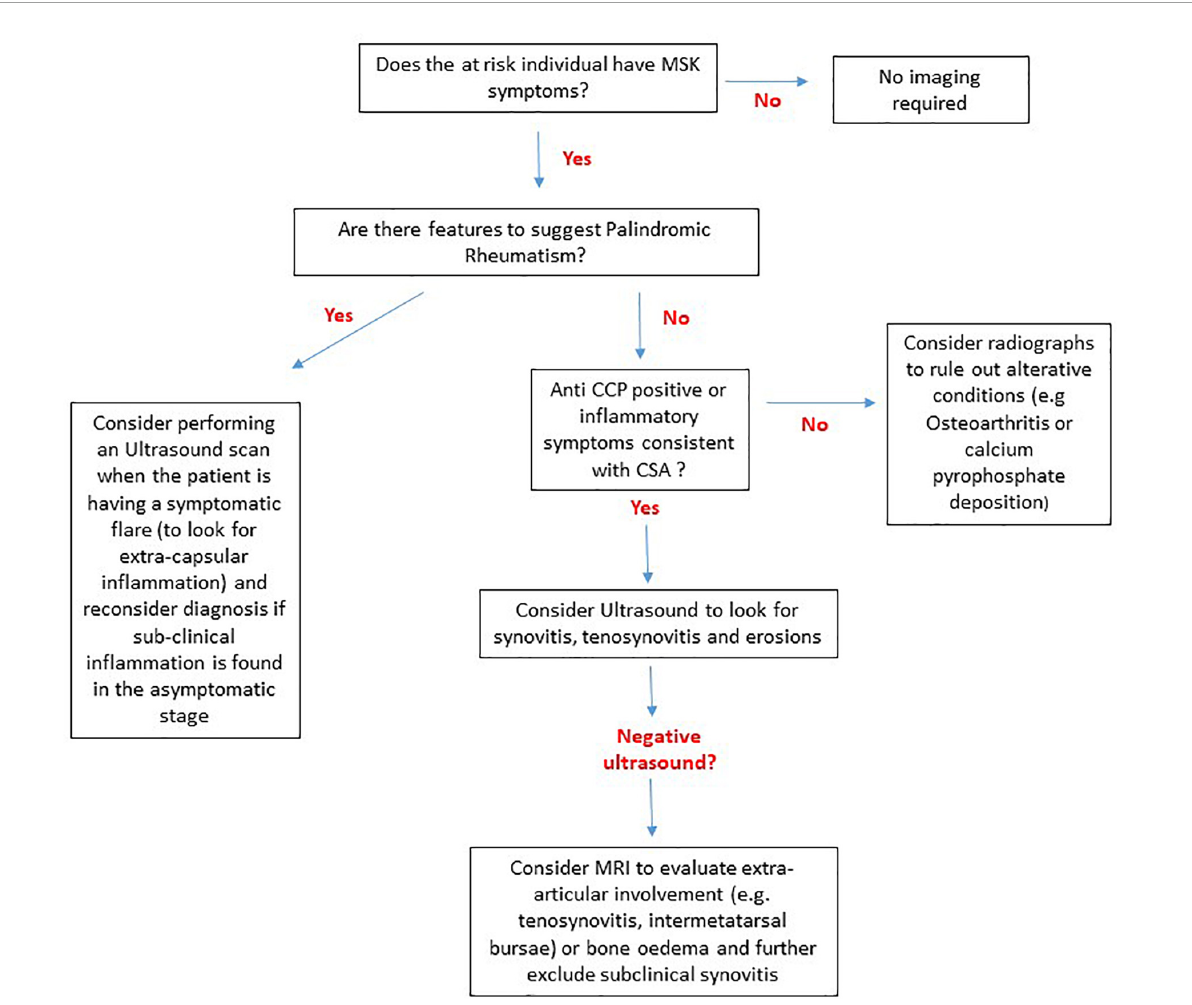
FIGURE4 A suggested algorithm to guide the use of MRI, US and radiography in individuals at risk of RA without clinical synovitis based on current evidence. In patients that do not have any symptoms there is no evidence to suggest that any imaging techniques are of diagnostic or predictive value. For Palindromic rheumatism extracapsular inflammation can be captured on imaging during flare episodes and if subclinical inflammation is seen in the asymptomatic phase the diagnosis of palindromic rheumatism should be re-considered. For anti-citrullinated protein antibody (ACPA) negative individuals with inflammatory symptoms i.e., clinically suspect arthralgia (CSA) and ACPA+ individuals an ultrasound should be performed. If the ultrasound is negative MRI may be able to detect subtle sub-clinical inflammation, particularly in extracapsular structures. For at risk individuals such as first-degree relatives with non-inflammatory musculoskeletal (MSK) symptoms radiographs should be performed to look for alterative